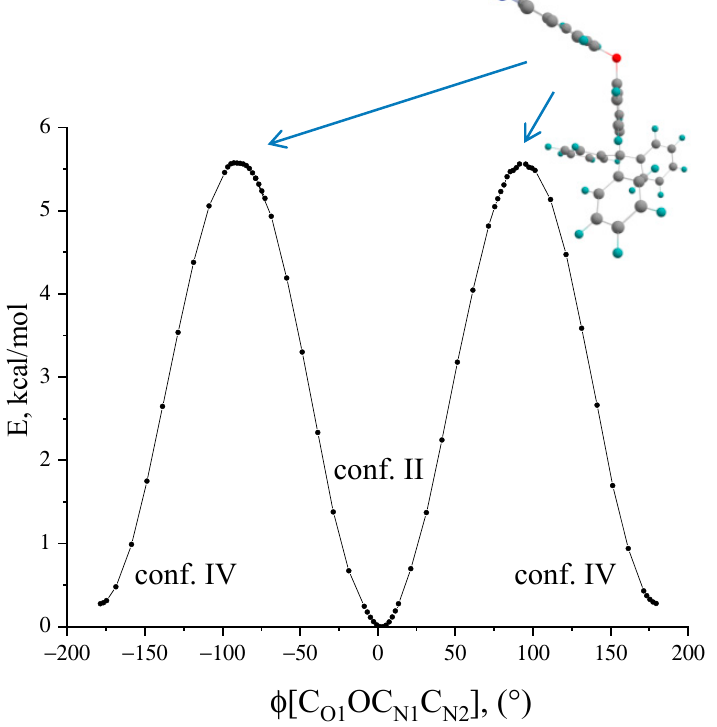
Figure 4. The potential function of internal rotation of PhO-PhN group around the C O4 -C t bond in cis -conformers I and II. On the right: TS structure.